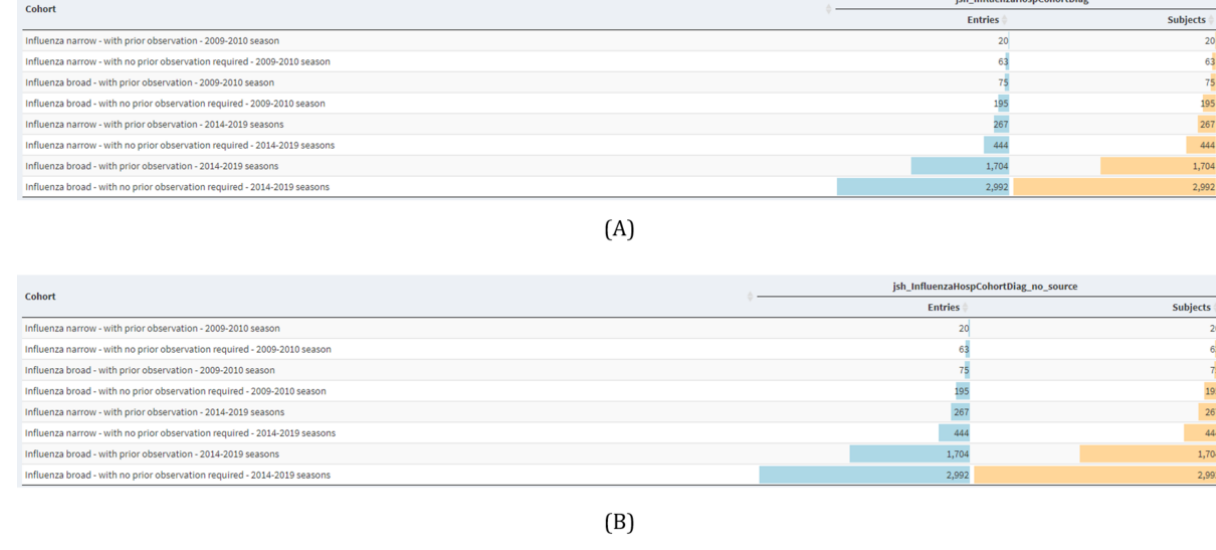
Figure 1. Generated cohorts for “Influenza Cohort Diagnostics” study (A) without de-identification and (B) with the proposed de-identification